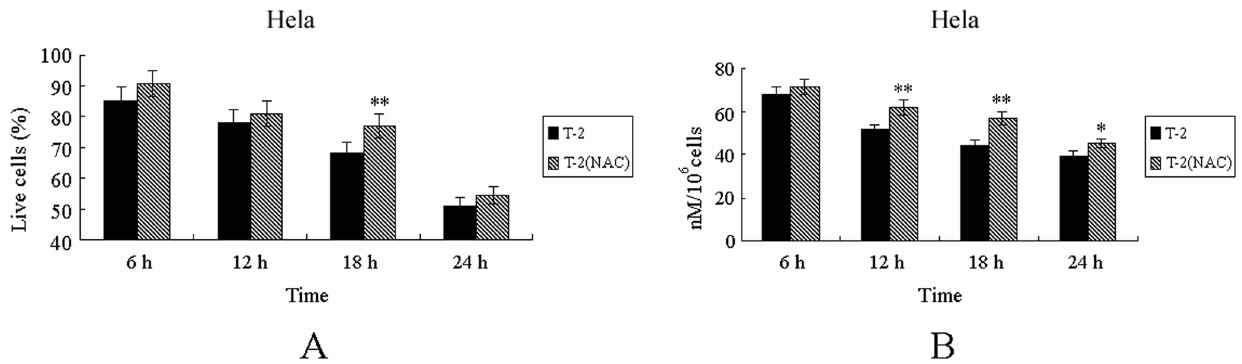
Figure 3. Antioxidation of NAC in cell death induced by T-2 toxin. A . Antioxidation of NAC in the cell death process of Hela cells. B . Endogenous GSH level of Hela under protection of NAC. Data was presented as mean 6 SD. *p , 0.05, **p , 0.01, ***p , 0.001.